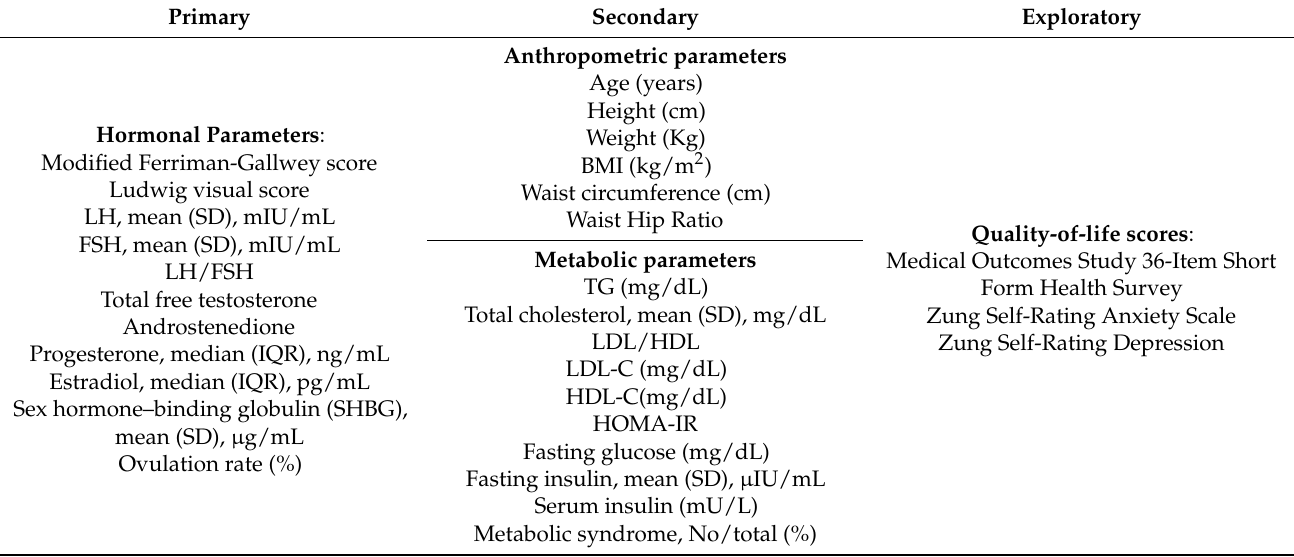
Table 3. Primary, secondary, and exploratory outcomes that will be used in the